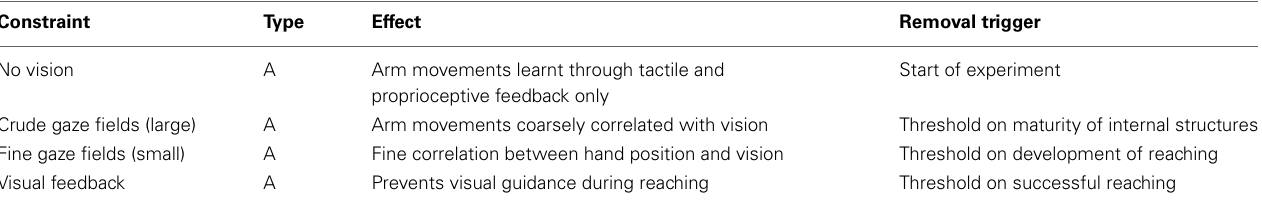
Table 4 | Constraints used to structure reaching stages in